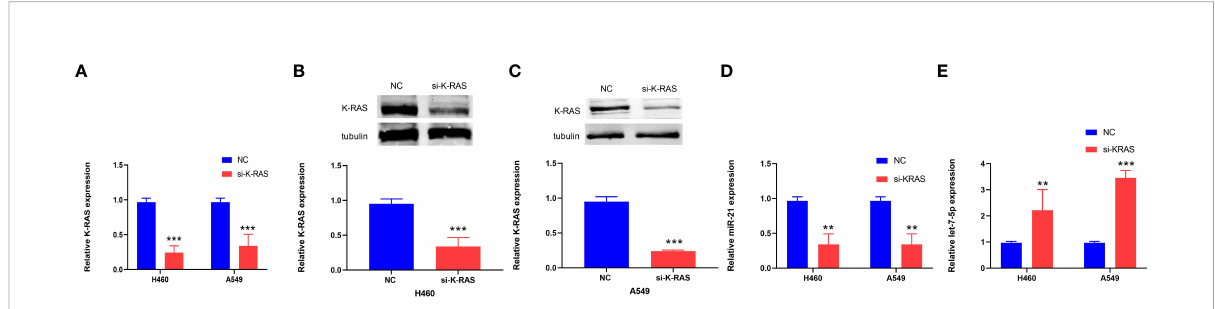
FIGURE 8 The expression of K-ras in cells and the relationship to miR-21 and let-7. (A – C) qRT-PCR and Western blot analyses showing downregulation of K- ras following transfection with K-ras siRNA into H460 and A549 cells. (D, E) qRT-PCR results showing that downregulation of K-ras in H460 and